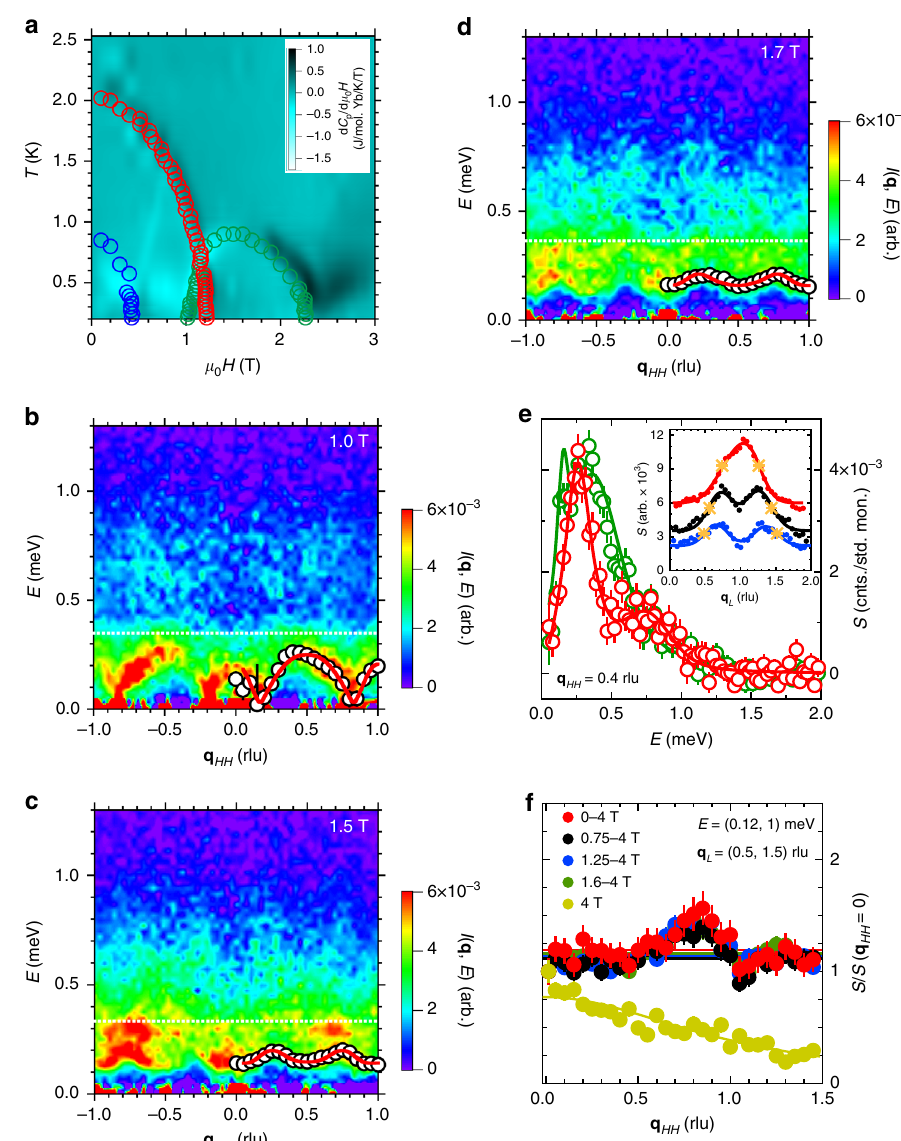
Fig. 3 A coherent, longitudinal interchain mode in Yb 2 Pt 2 Pb. a The fi eld-temperature phase diagram of Yb 2 Pt 2 Pb deduced from speci fi c heat measurements (see Supplementary Note 3). Symbols representing phase lines of the low fi eld AFM order (red), gapped phase when k B T < Δ S (blue), and second, weaker order (green) are obtained from the magnetic fi eld dependence of the magnetization along the (110) direction at fi xed temperatures. Refer to Fig. 2a for an example. Not all of the fi eld-induced AFM phases observed in the magnetization are shown. b – d The magnetic excitation spectrum along the q HH direction of reciprocal space measured at T = 0.1 K and μ 0 H = 1.0 T ( b ), 1.5 T ( c ), and 1.7 T ( d ), summed over 0 ≤ q L ≤ 2 rlu. The fi tted dispersion of the interchain mode is shown (white circles), as well as fi ts to the expression described in the main text (red lines). The mode dispersion and fi ts are only shown for q HH > 0 for clarity (see Supplementary Note 4). The continuum boundary appears at 2 Δ M 33 (white dashed line). e Example cuts of the energy dependence at q HH = 0.4 rlu measured at B = 1.0 (red) and 1.5 T (green). Fits are described in the text. The mode dispersions shown in b – d are extracted from such fi ts. (Inset) The integrated intensity of the scattering over the energy of the interchain mode extracted from the fi ts is shown in parts b – d as a function of momentum q L along the chain. Magnetic fi elds of 1.0 T (red), 1.5 T (black), and 1.7 T (blue) are offset for clarity. q L = 1±2 k F is shown at each fi eld (gold stars). f The polarization of the excitations follows the projection onto the scattering vector q of the magnetic moments contributing to the scattering, indicating that all observed excitations are longitudinal (see Supplementary Note 5). Fields and integration ranges are given in the fi gure legend; the calculated polarization was averaged within the corresponding q L integration range. Error bars represent one standard deviation and where not visible are smaller than symbol new mode is roughly resolution limited at all fi elds, and it is relative spectral weight of the continuum grows. We model the always distinguishable from the spinon continuum for fi elds energy dependence of the scattering at a speci fi c q HH as a damped μ ≤ 1.7 T. The connection of the mode and the con fi ned spinon harmonic oscillator (DHO) response centered at the mode 0 H states can be emphasized by integrating over the energies of the position and the product of a Lorentzian and step function mode and plotting the intensity as a function of momentum accounting for the continuum at higher energies, all convolved along the chains (Fig. 3(e-Inset)). At all fi elds, ≈ 85% of the with the instrument resolution (Fig. 3e). The energy width of the